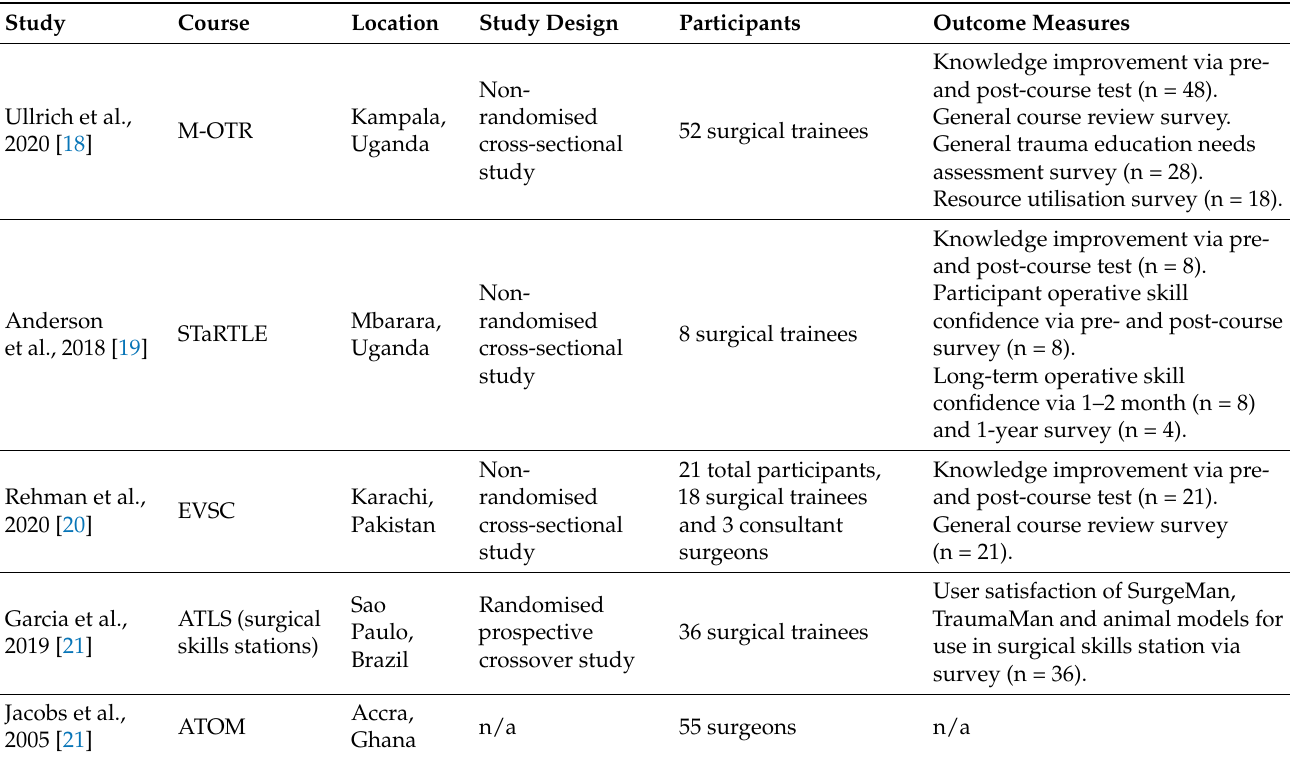
Table 3. Study Characteristics.